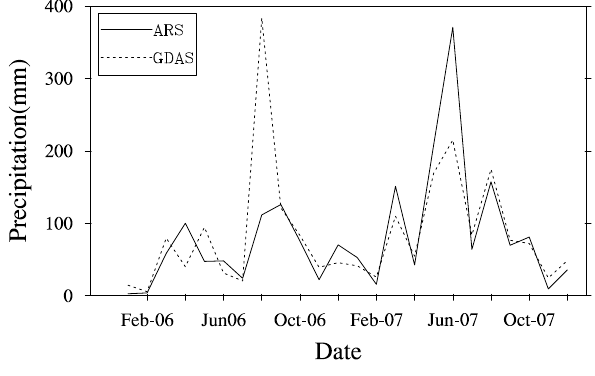
Fig. 2. Basin averaged monthly ARS and GDAS